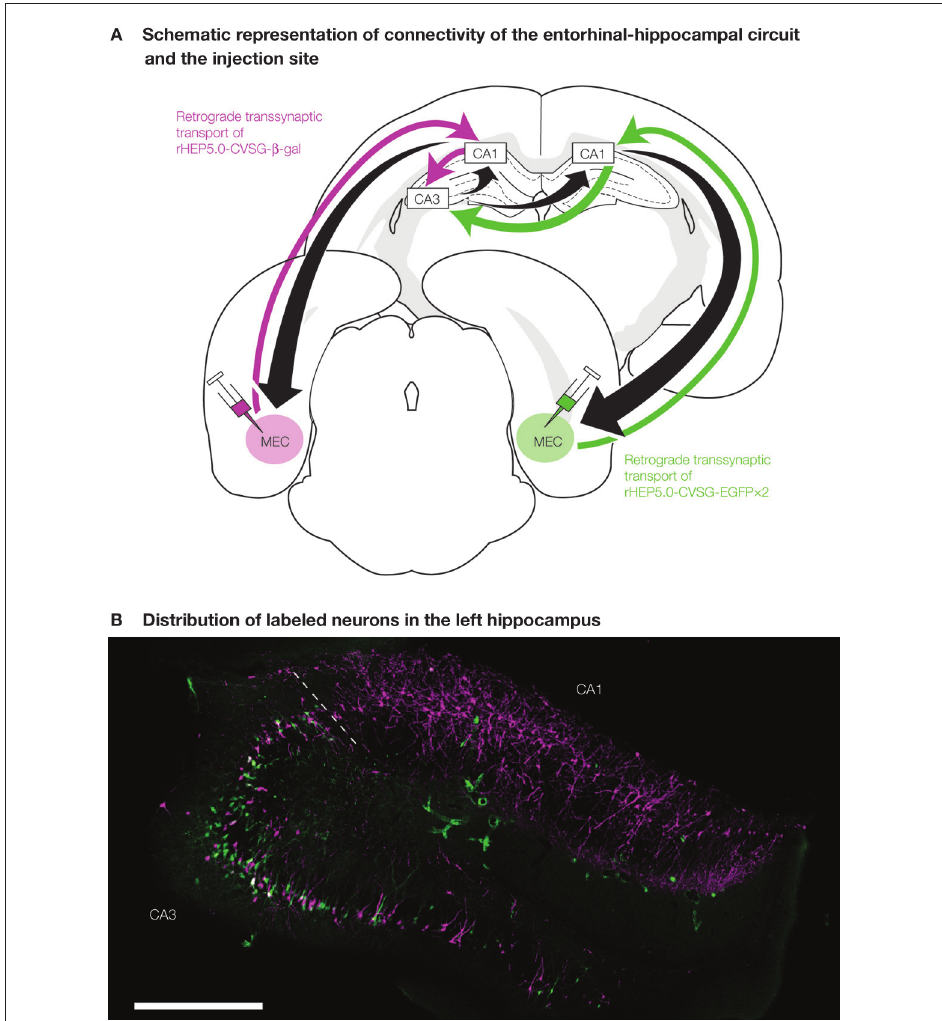
Figure 3 | Experimental design of dual viral tracing in the rat entorhinal-hippocampal circuit. (A) rHEP5.0-CVSG- β -gal and rHEP5.0-CVSG-EGFPx2 were injected to the left and right MEC, respectively. The viruses, transsynaptically transported from the bilateral MEC will go through CA1 and will first meet in the hippocampal CA3 region. (B) In field CA1, neurons are labeled only by the virus (rHEP5.0-CVSG- β -gal) injected into the ipsilateral MEC, whereas β -gal (magenta) and GFP (green) labels intermingle in CA3 region. Note that there are double-labeled neurons (white) in CA3. MEC, medial entorhinal cortex. Scale bar = 500